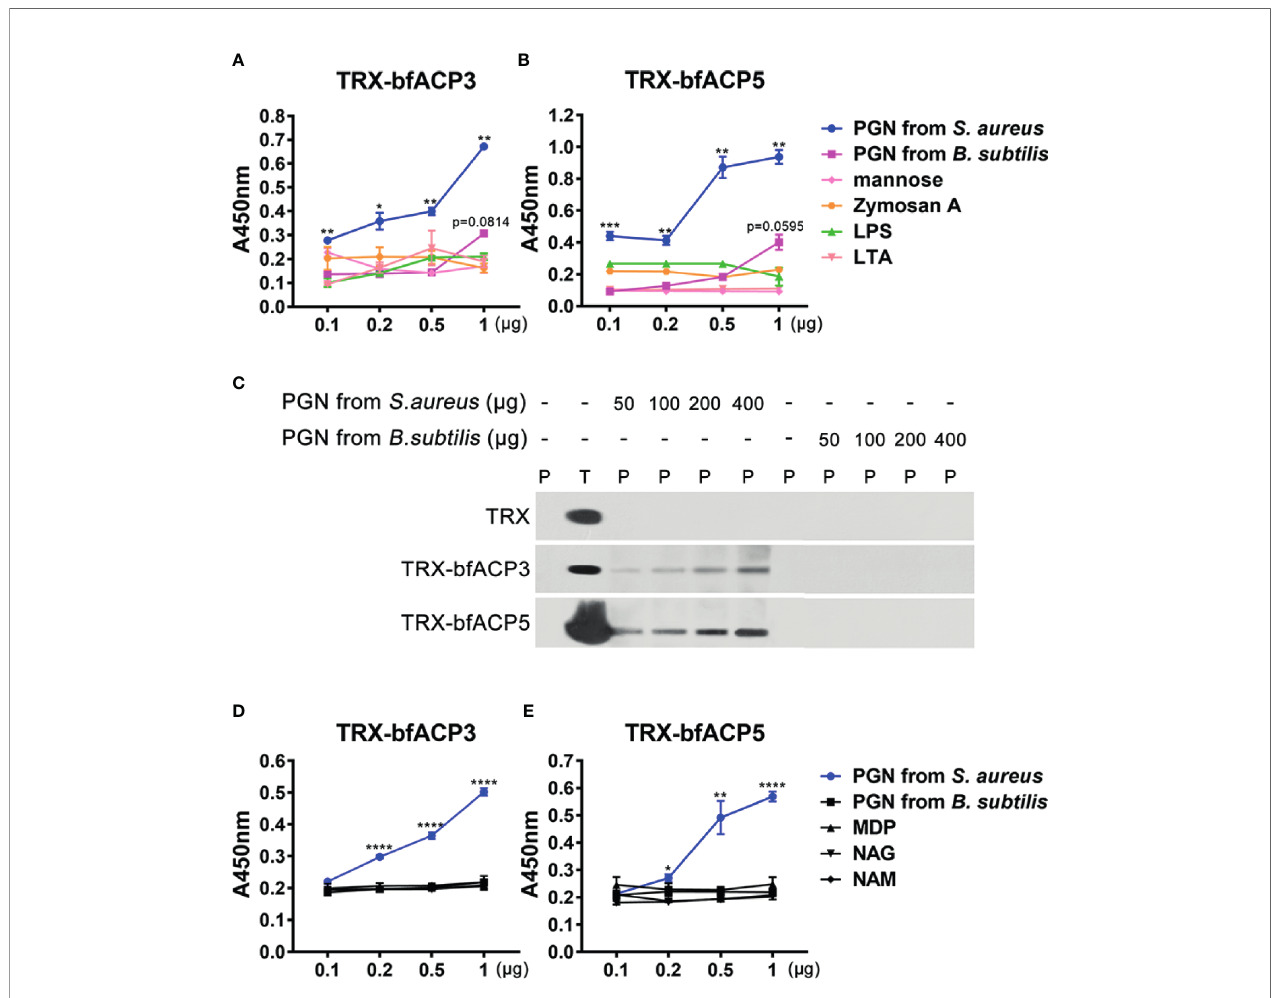
FIGURE 5 | BfACP3 and bfACP5 directly interacted with the components of the microorganism cell walls. (A, B) ELISA analysis of the interaction between recombinant fusion TRX-bfACP3 and TRX-bfACP5 to the components, respectively. Plates were coated with 20 m g components, incubated with TRX-bfACP3 or TRX-bfACP5 at 37°C overnight and detected with anti-6×His monoclonal antibody. Three biological replicates were designed for each experiment, and three technical replicates were performed, showing one of the representative results. Background absorbance with TRX was subtracted. (C) Pull-down analysis of the binding of 5 m g recombinant fusion ACPs to PGN from S. aureus or B subtilis . P, pellet protein; T, total protein. (D, E) ELISA analysis of the interaction between recombinant fusion ACPs and 20 m g monomers that are parts of peptidoglycan. NAG, GlcNAc; NAM, MurNAc. * p < 0.05, ** p < 0.01, *** p < 0.001, **** p <